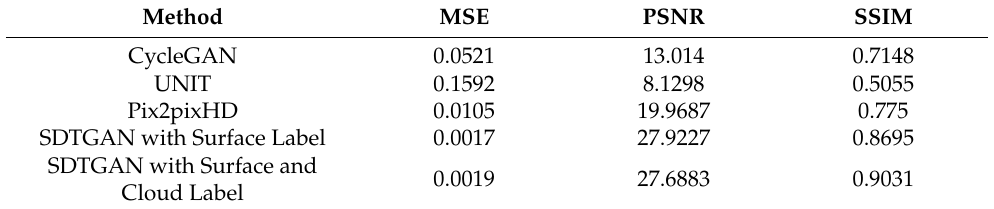
Table 5. Quality result of the translation from visible spectrum domain to infrared spectrum domain.